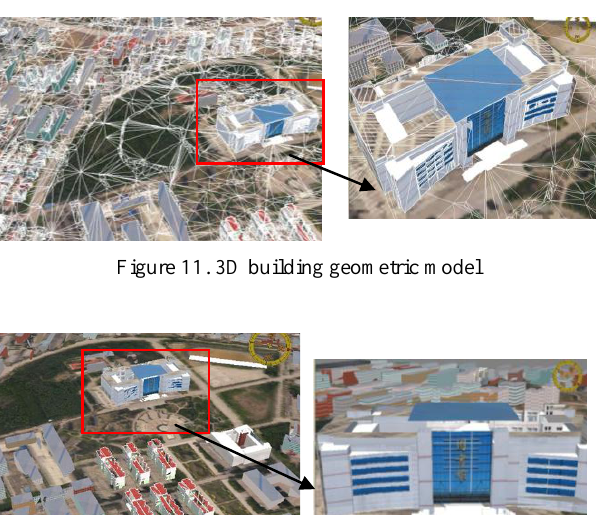
Figure 9. 3D building geometric model